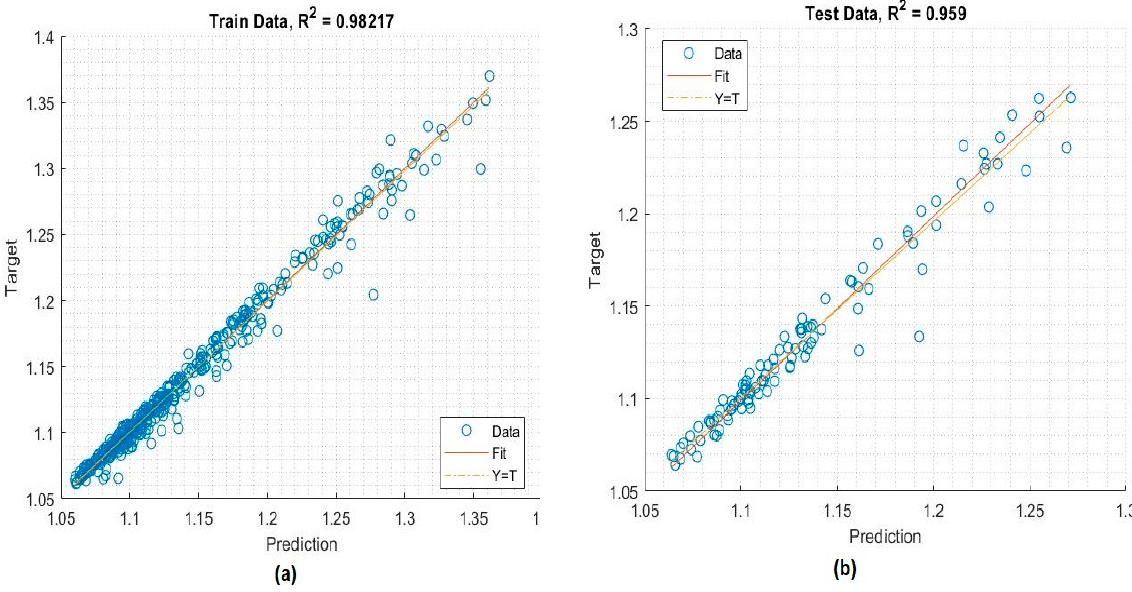
Figure 10. Performance of the MLP model for predicting bitcoin price: ( a ) training phase and ( b ) testing phase. Table 4. Comparison results between the proposed system and the existing models.